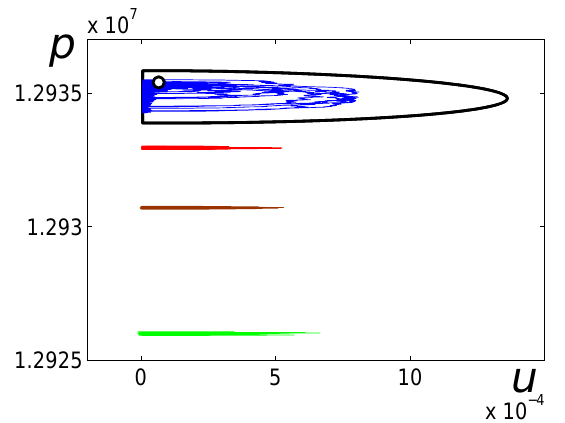
Figure 7. Displacement d (m) as a function of time t (s) under the influence of F noise: deterministic case (black), ε = 10 − 4 (blue), ε = 5 × 10 − 4 (red), and ε = 10 − 3 10 − 4 (red), ε = 7 10 − 4 × ×